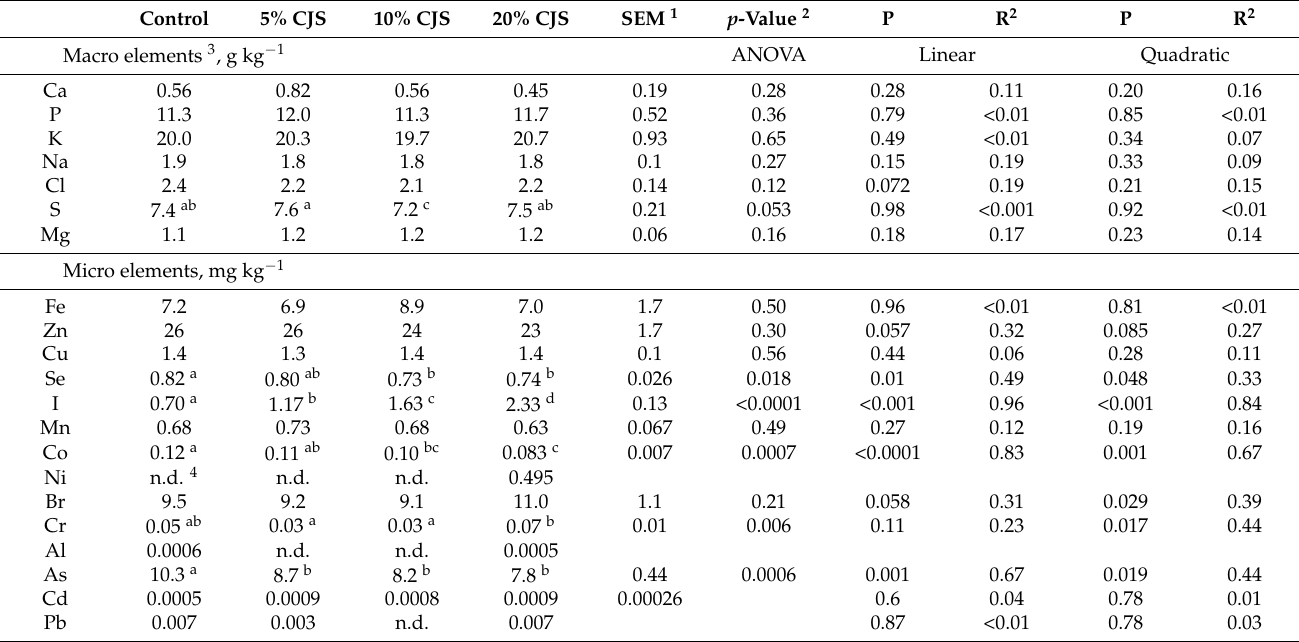
Table 8. Macro and micro minerals present in the muscle of Atlantic salmon ( Salmo salar ) from the retention experiment where salmon were fed increasing dietary level of Cyberlindnera jadinii